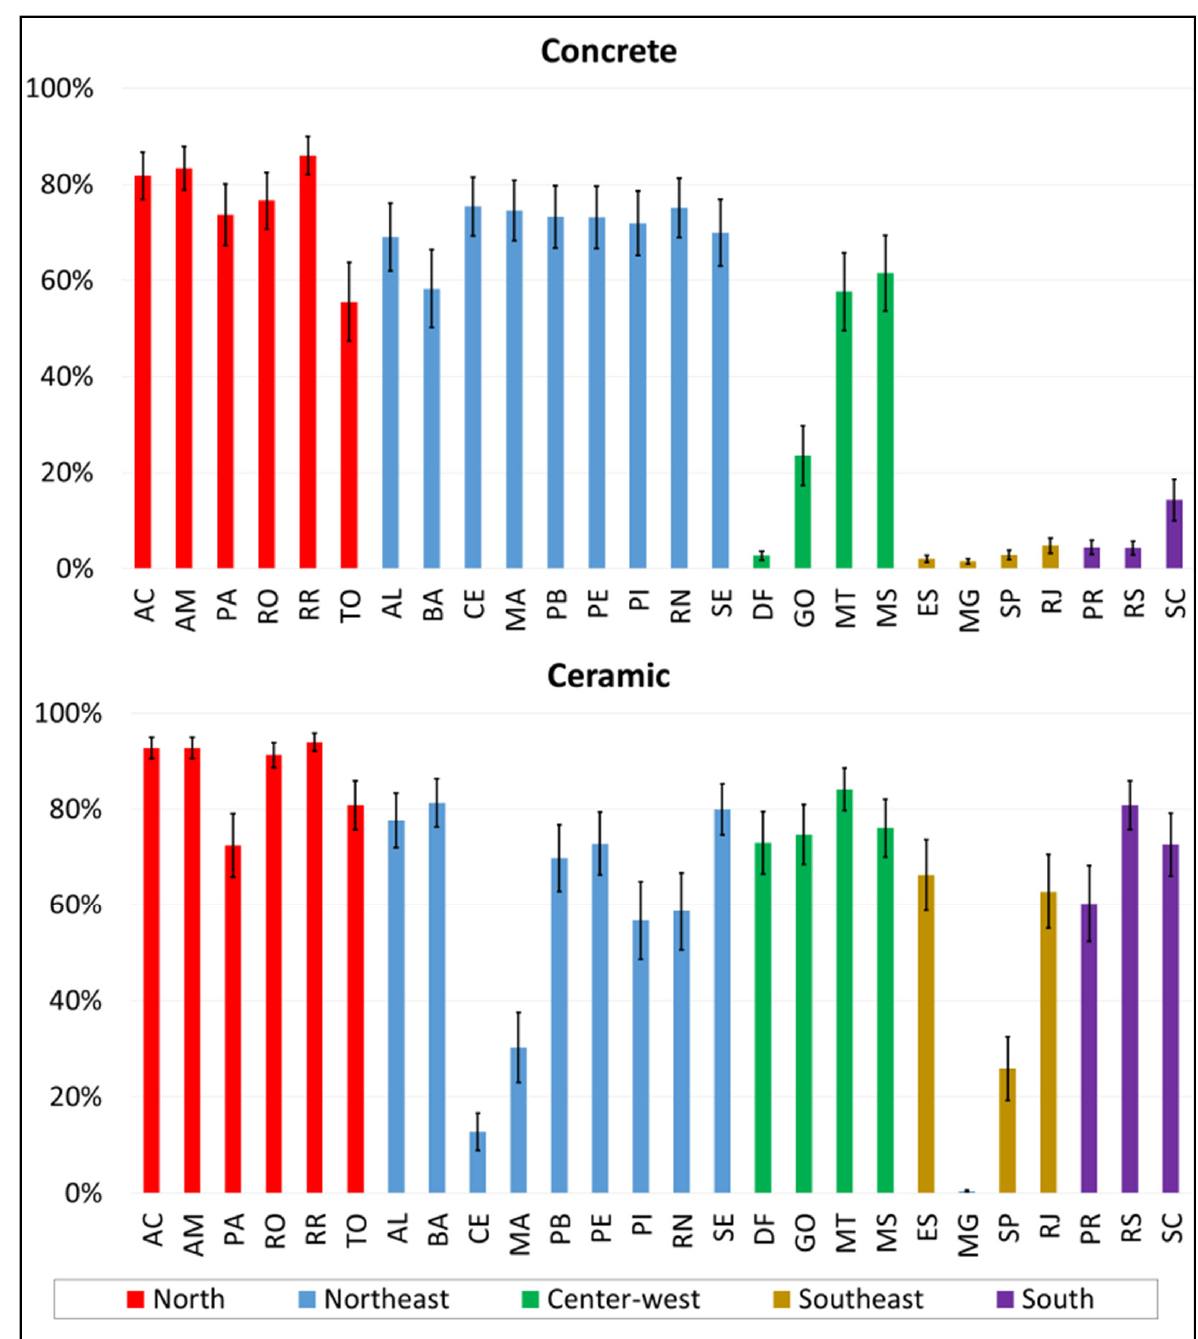
Figure 11. Percentage of the transportation stage in the Resource Depletion impact. The error bars represent the standard deviation due to transportation scenarios.